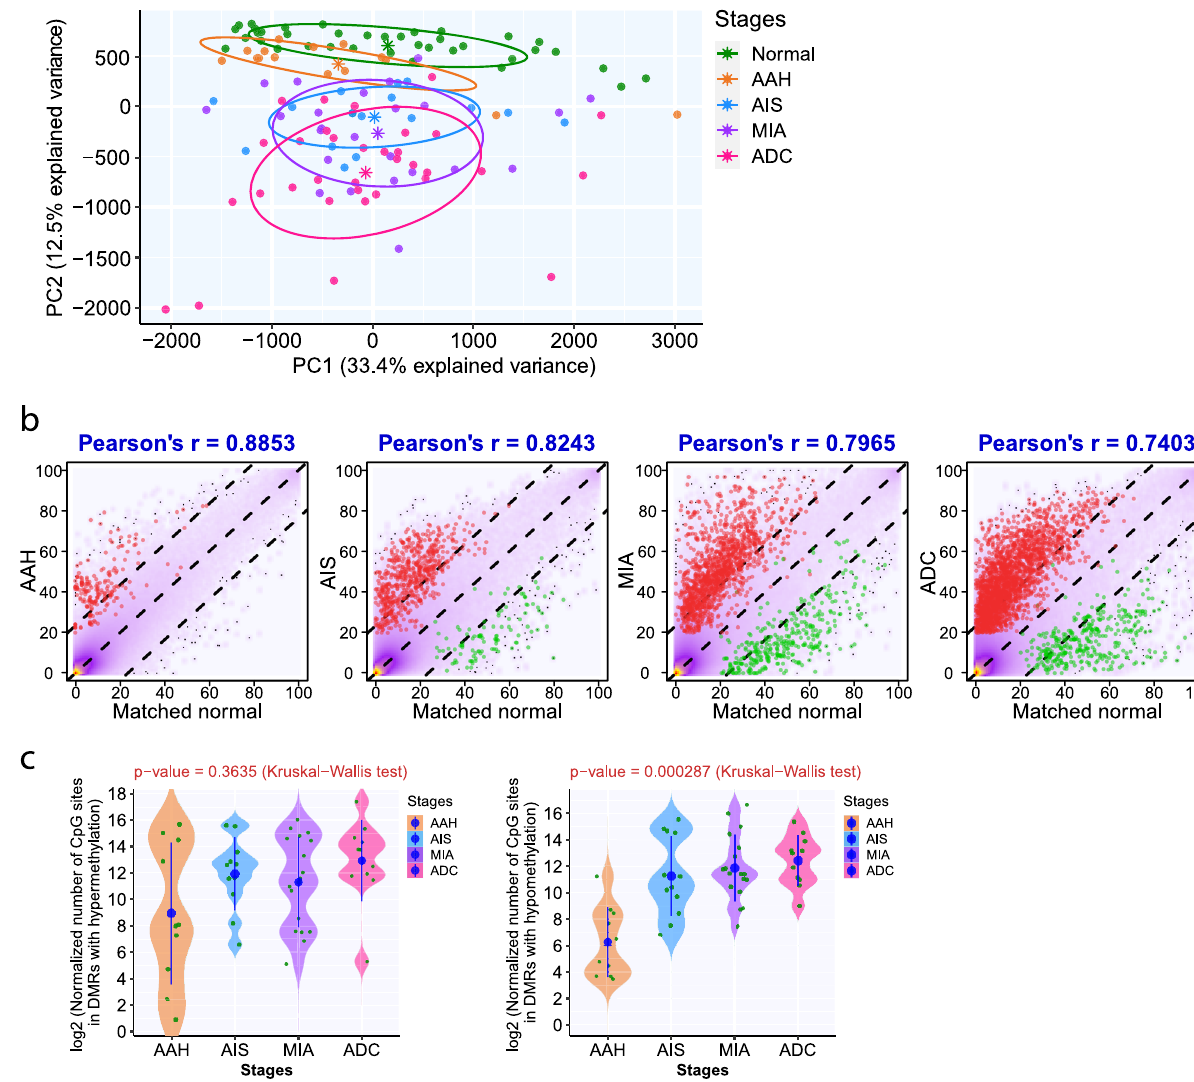
Fig. 1 DNA methylation aberrations increase with the progression of precancers. a Principal component analysis of the methylation pro fi les of the average methylation values in 39,148 5-kb tiling regions (shared in all samples) composed of autosomal, non-polymorphism CpG sites supported by at least 10× read coverage in IPNs of different stages. The solid dots of different colors represent IPNs of different stages and the star (*) represented the centers of specimens of each histologic stage. b Overall genome-wide DNA methylation correlation between IPNs of different stages and matched normal tissue from the same patients. The yellow-purple clouded dots in the smooth scatter plot represent the CpG sites covered by IPN specimens ( n = 14 for AAH, n = 11 for AIS, n = 18 for MIA, n = 10 for ADC) and paired normal lung. Two-tailed Pearson ’ s correlation coef fi cient r values are shown on the top. P < 2.2 × 10 − 16 in all four histologic stages. The red dots represent CpG sites with hypermethylation in IPNs (within DMRs of methylation gain in IPNs and methylation ≤ 20% of CpG sites in the corresponding normal lung) and the green dots represent CpG sites with hypomethylation (within DMRs of methylation loss in IPNs and methylation ≥ 20% of CpG sites in the corresponding normal lung). c The number of CpG sites overlapping with DMRs showing hypermethylation (left) or hypomethylation (right) in IPNs of different histologic stages. The green dots represent the mean of normalized numbers of CpG sites overlapping with DMRs in each IPN. The solid blue dots represent the mean numbers of CpG sites overlapping with DMRs in IPNs of each histologic stage with a 95% con fi dence interval as error bars. The differences among all stages were assessed using the Kruskal – Wallis H test. Source data is provided as a source data fi